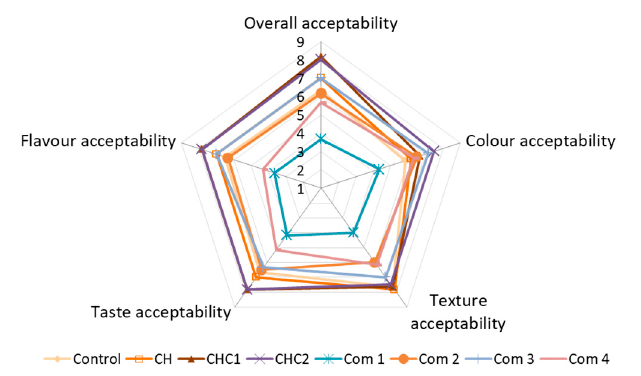
Figure 4. Overall acceptability of developed reduced-fat gluten-free cookies (CH, CH1, CH2), com- pared with full-fat cookie (Control).